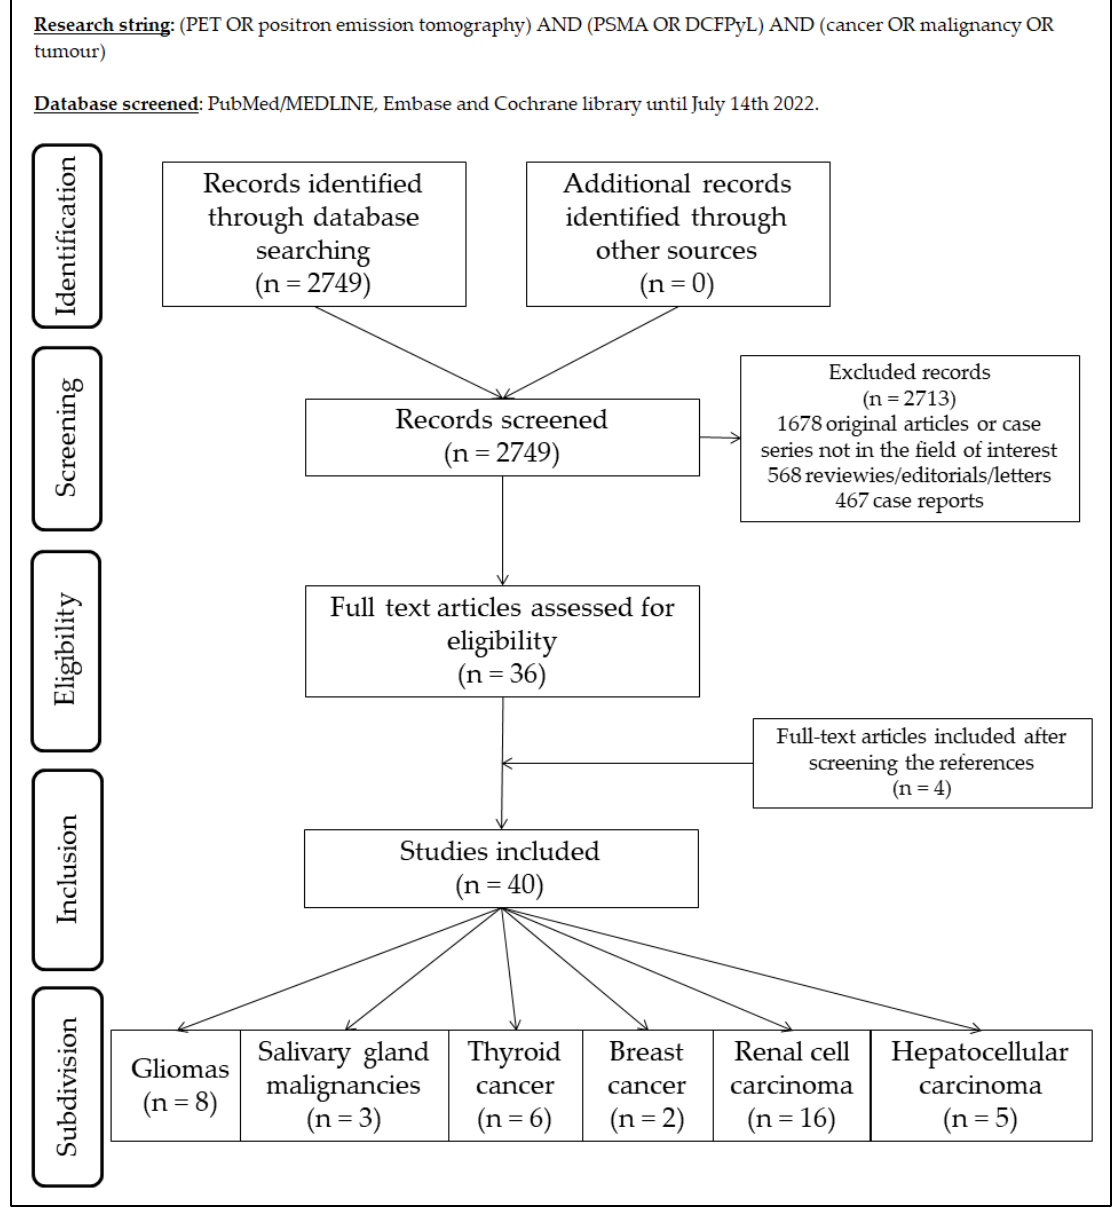
Figure 1. Summary of study selection process for the review .